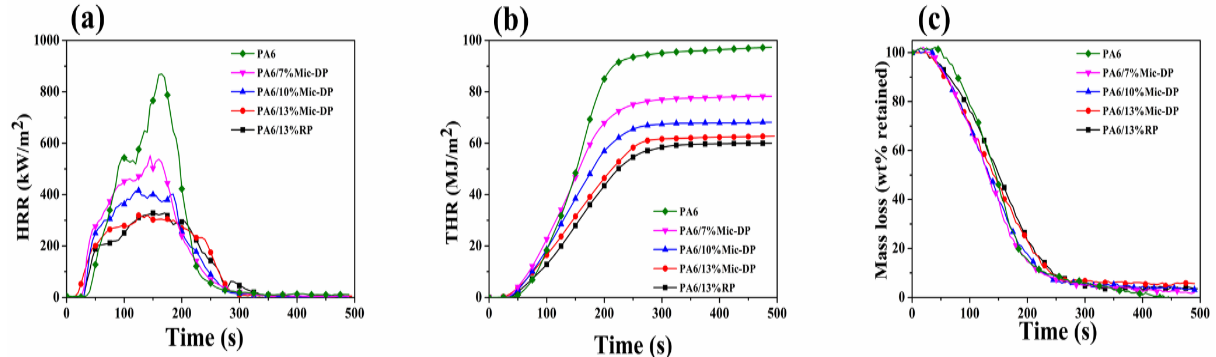
Figure 5. HRR ( a ), THR ( b ), and mass loss curves ( c ) of PA6 samples. The peak HRR (pk − HRR) and THR of PA6 were 869.5 kW/m 2 and 96.7 MJ/m 2 , respec-